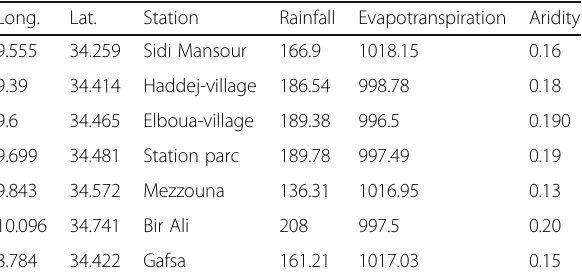
Table 3 Main climatological data for study area (NASA n.d.-b) Long.